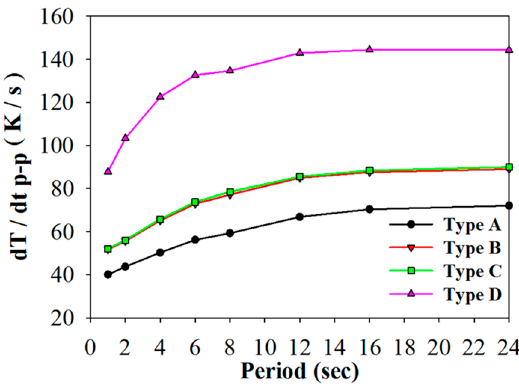
Figure 9. Relationship between the peak to peak temperature variation rate and period for using the PZT cells with various structures.